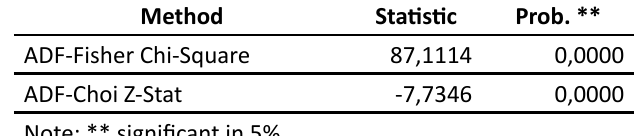
Table 1: Augmented Dickey Fuller Test at First Difference Level